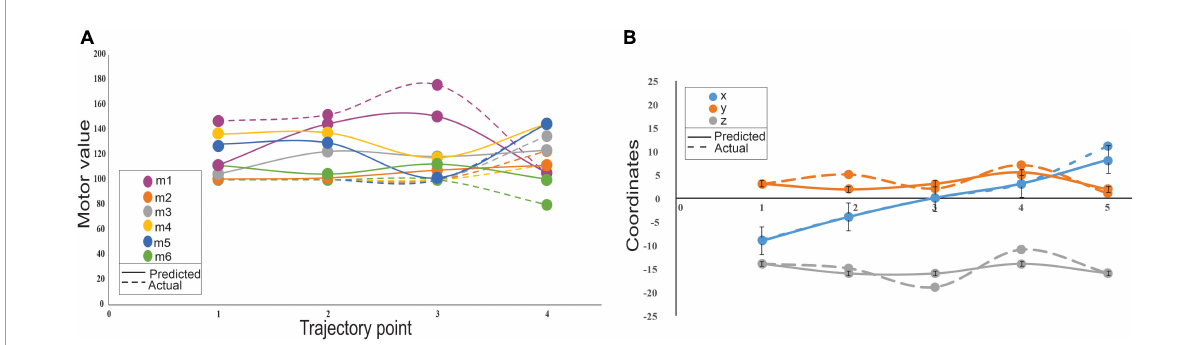
FIGURE7 Variability on sensory and motor prediction for a 4-point trajectory by a low-cost arm. (A) Motor variability: Variability of the motor predictions was carried out using the cerebellar model that predicts the motor consequences from sensory commands. Motor errors were calculated from the actual values (dotted lines) and predicted (solid lines) for 6 motors. (B) Sensory variability: Sensory consequences of the predicted motor values were calculated using forward kinematics and errors associated were calculated as the difference from the actual to the predicted end-effector coordinates. Sensory error representations showed minimal variations and represented in the error bars some of which were negligibly small and very insignificant to be